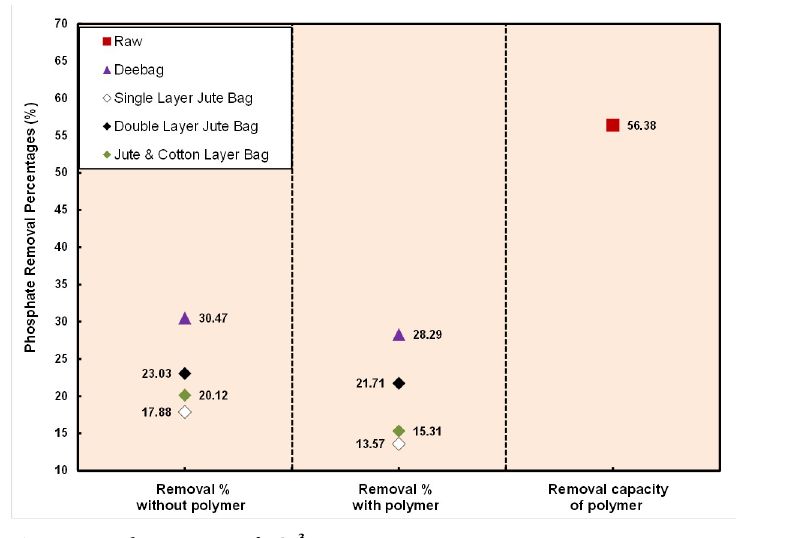
Fig 5. Removal percentages of PO 43-